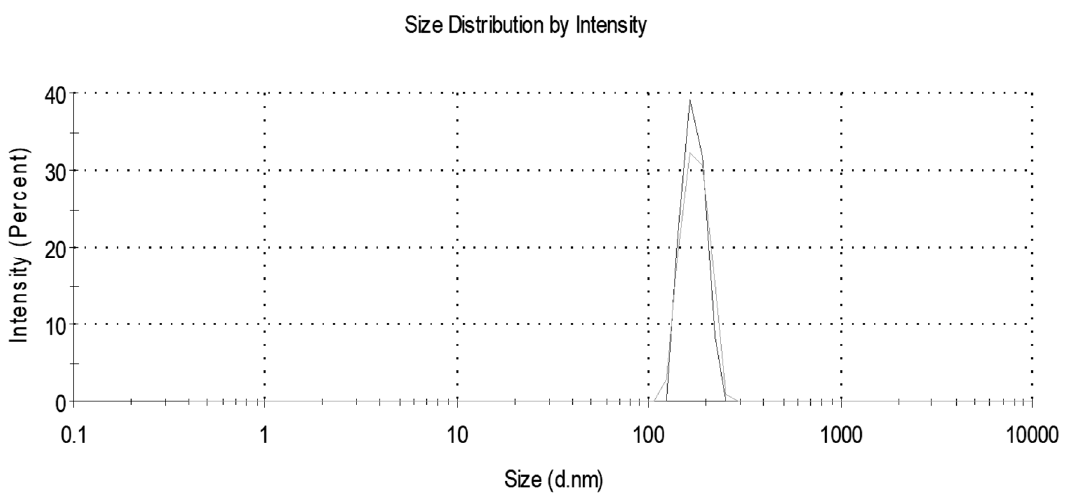
Figure 4. Particle size distribution of nanoplastic particles (Nano ZS Zetasizer) following filtration (pore size 0.22 µ m). Lines indicate replicate results.